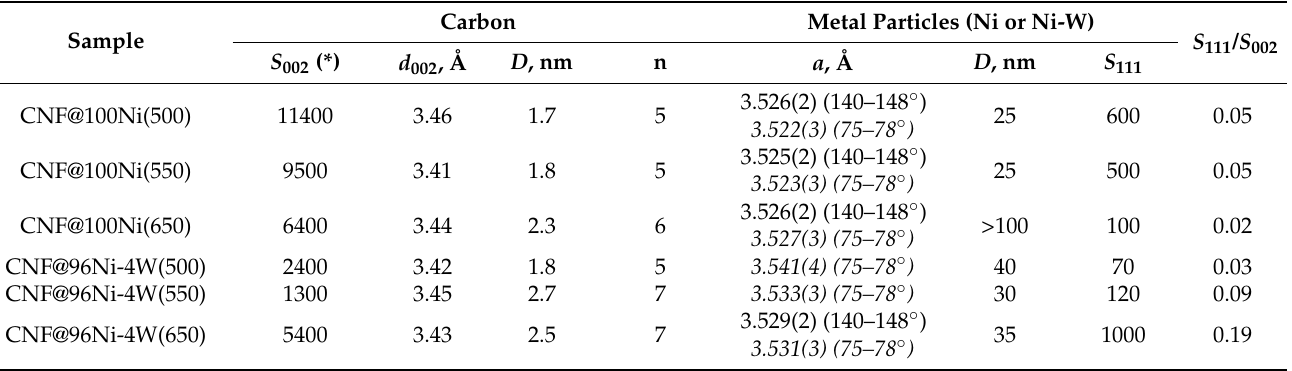
Table 2. XRD data for the carbon nanomaterials produced over 100Ni and 96Ni-4W samples in a temperature range of 500–650 ◦